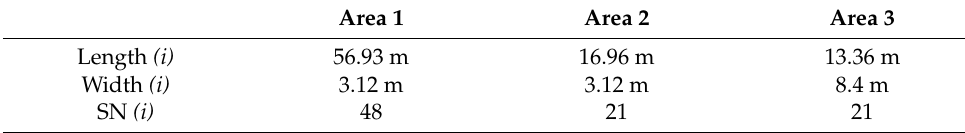
Table 11. Environment